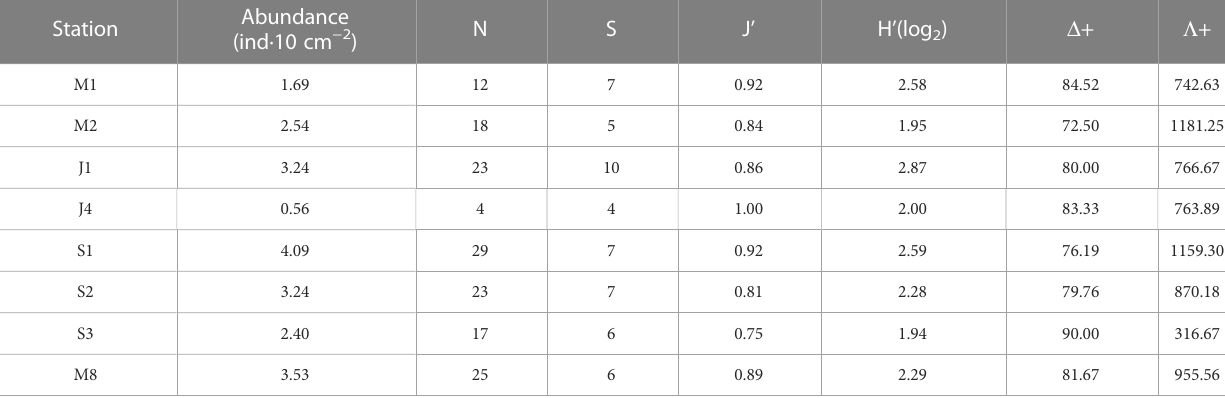
TABLE 2 Biodiversity and abundance of marine tardigrade fauna from different stations in the South China Sea.